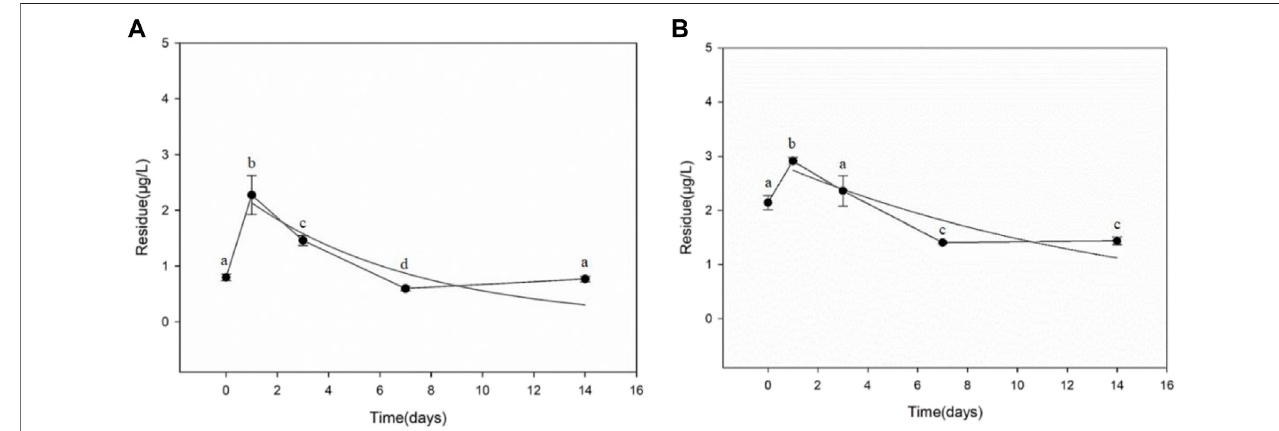
FIGURE 4 | Dissipation of difenoconazole in paddy sediment. (A) Chemical fertilizer treatment plot. (B) Biogas residue treatment plot. Error bar is S.D. ( N = 3). Different lowercase letters denote signi fi cant differences ( p < 0.05), analyzed by ANOVA followed by Duncan multiple comparison